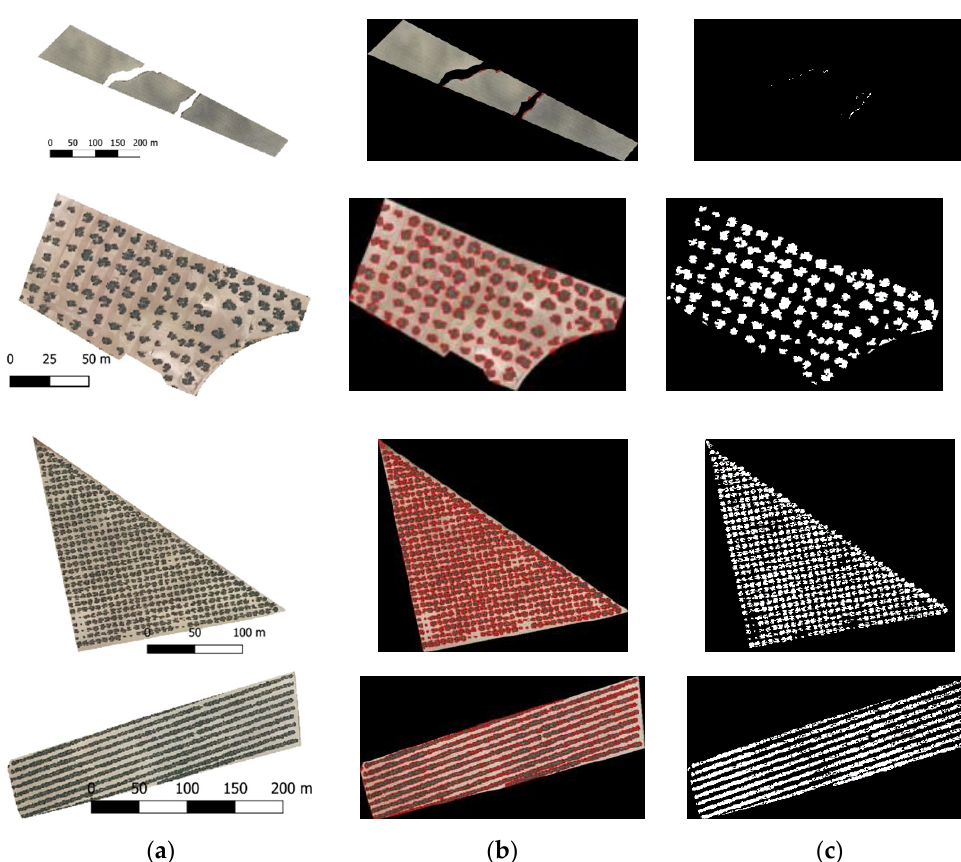
Figure 8. Processing result of 4 plots (14,900,40,60; 23,60,3,88; 14,57,1,58; 14,57,2,49); ( a ) Input image; ( b ) Image.tiff at the output; ( c ) Binary mask with the objects detected. Individualized information was obtained from the units of interest at the polygon and plot level. These processed data form part of the olive grove inventory, which served as support for advanced analytical